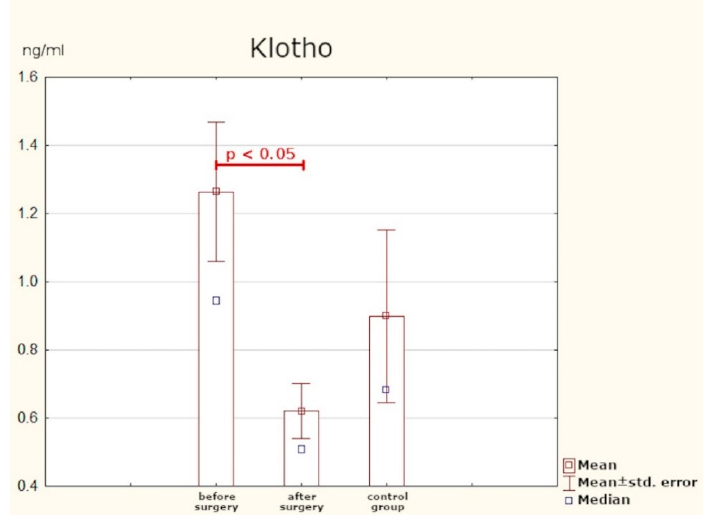
Figure 3. Serum concentrations of Klotho protein.